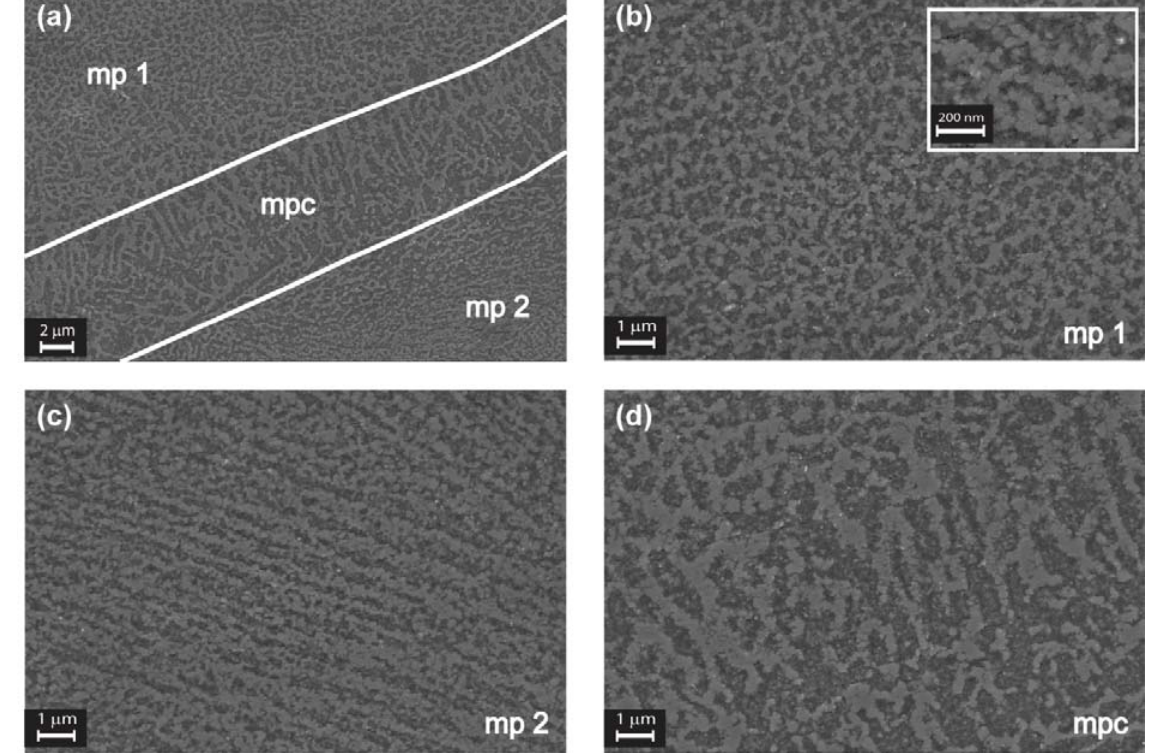
Figure 8. FESEM images of an aluminum alloy DMLS sample after etching with Weck’s reagent, sectioned along the z axis: ( a ) mp while the region delimited by the white lines correspond to the melt pool contour (mpc); ( b – d ) the three regions at higher magnifications. In the inset, it possible to observe the nanometric grain